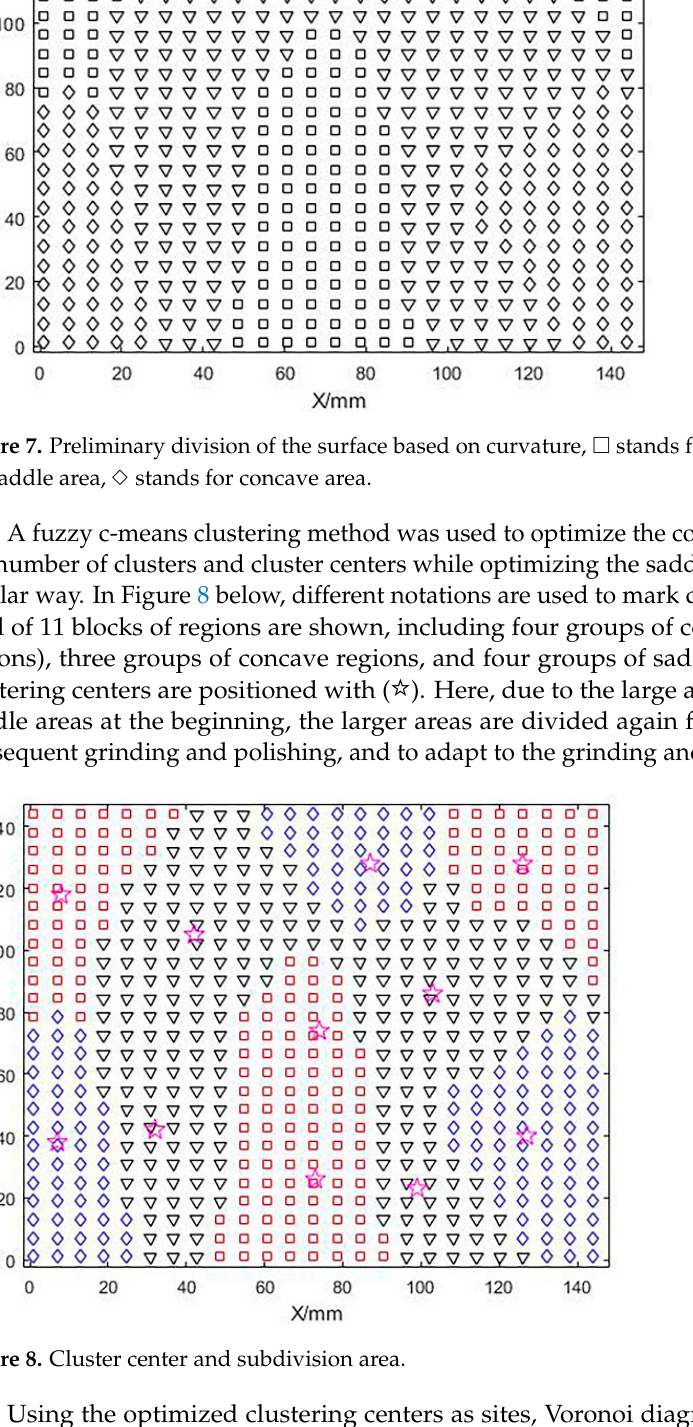
Figure 8. Cluster center and subdivision area.